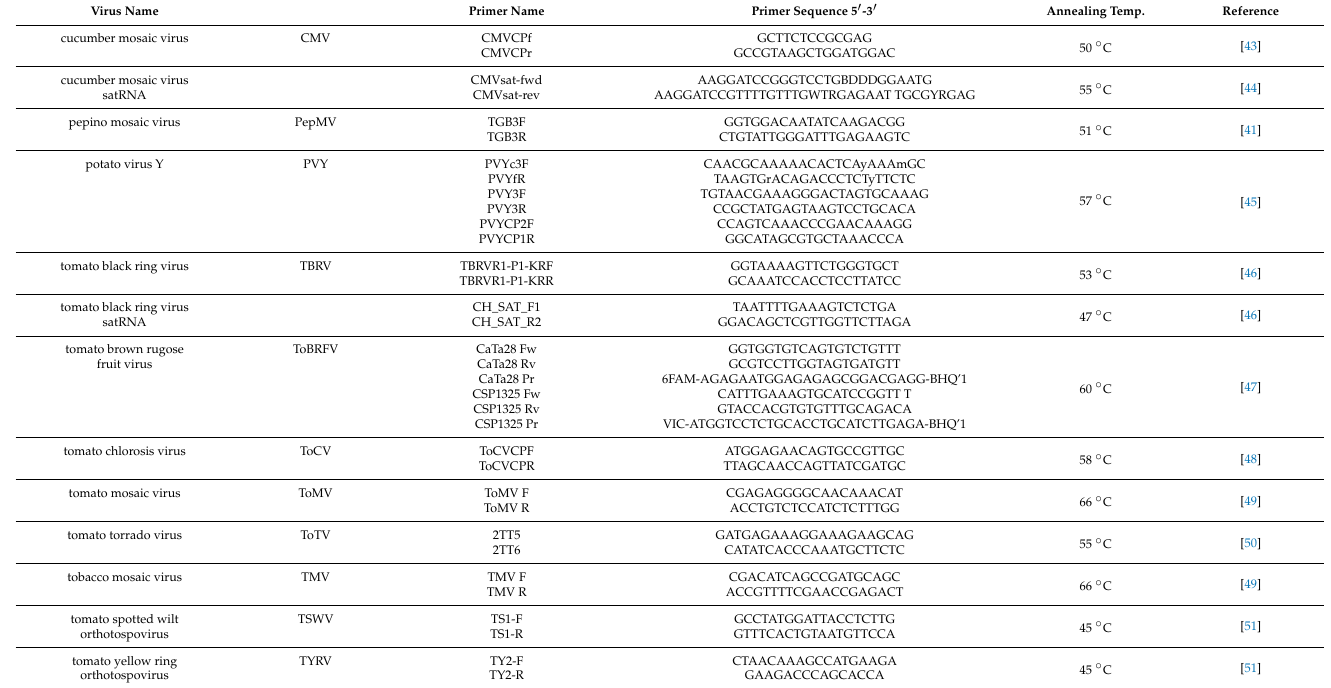
Table 1. Primers used in tomato virus